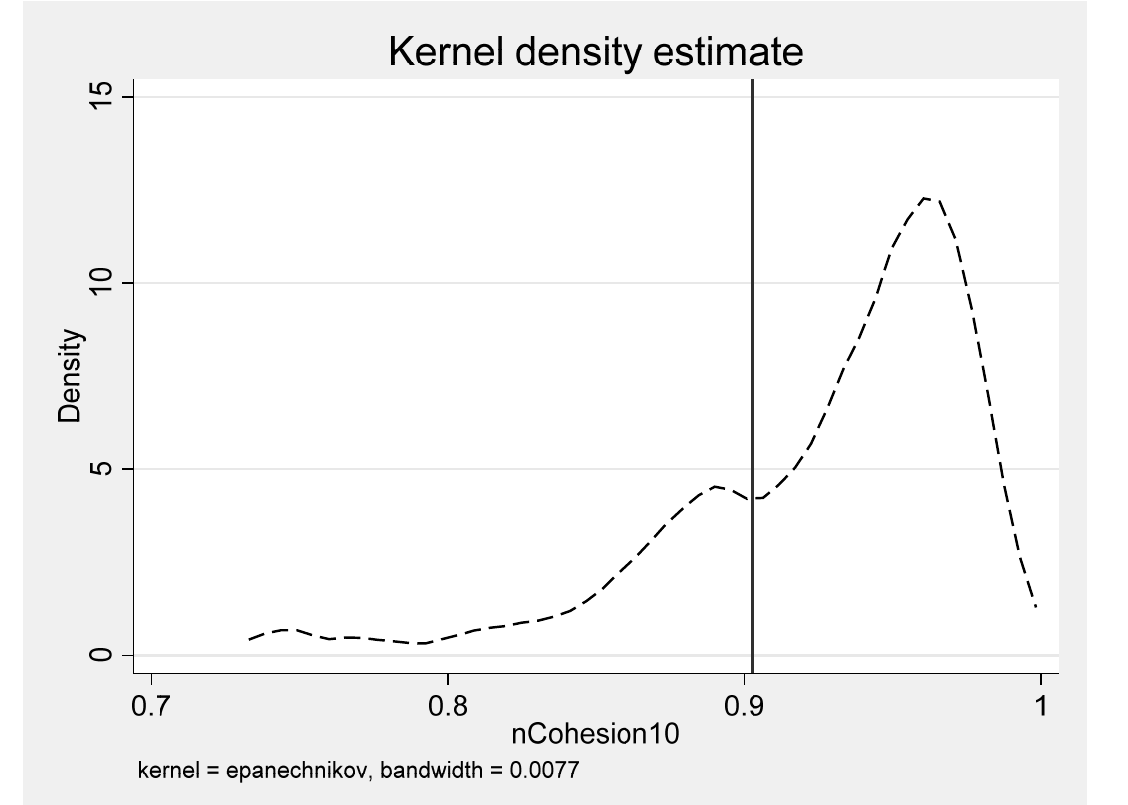
Figure 3. The Epanechnikov kernel density estimate of nCohesion10. Notes: The solid line acts as the symmetry axis of the inverted-U shape.